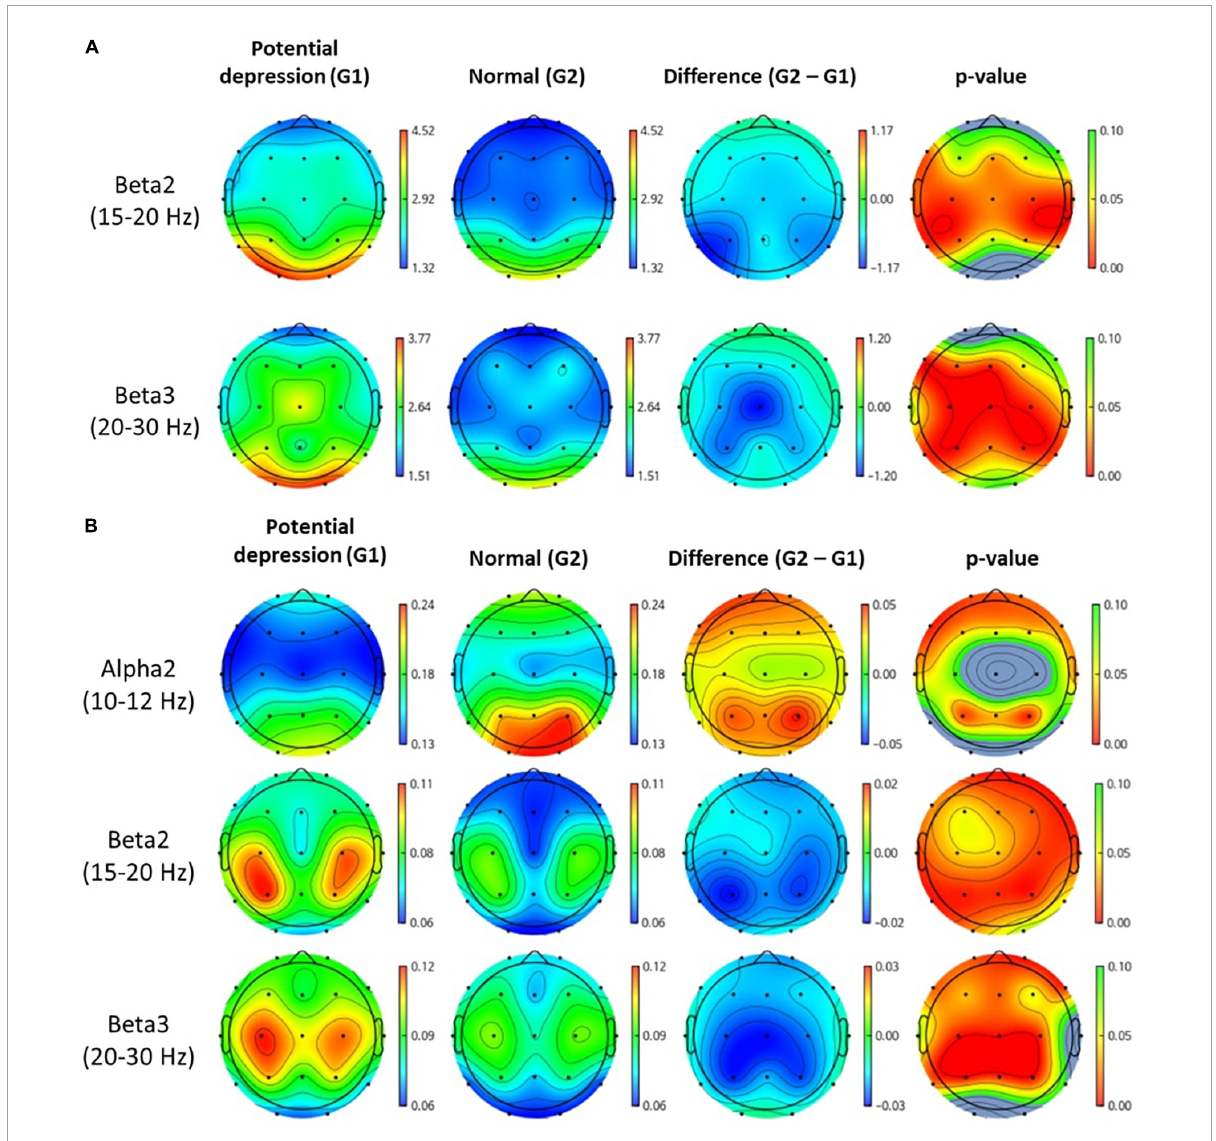
FIGURE3 Topomap of frequency bands that have significant difference between groups. Unit of spectral power is µ V 2 . (A,B) Represent absolute power and relative power of each group,